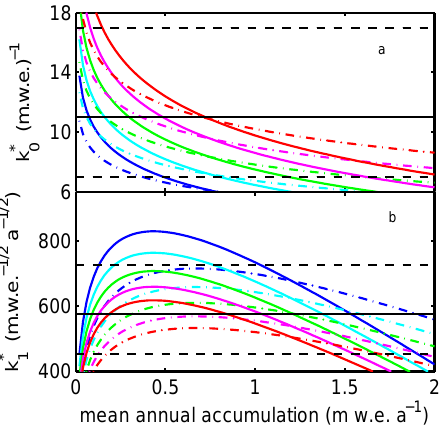
Figure 1. Vertical densification rates for ( a ) Stage 1 and ( b ) Stage 2 densification. Black lines show the Herron and Langway values (solid lines) with their uncertainties (dashed lines). Colored lines show the Ligtenberg values for mean annual temperatures of 230 (blue), 240 (cyan), 250 (green), 260 (magenta), and 270 K (red), with solid lines for Antarctic sites and dashed lines for Greenland sites. Simonsen et al. [15] modified the Arthern model by multiplying the r.h.s of Equation (13) by a simple scaling factor f 0 , and the r.h.s. of Equation (14) by another scaling factor f 1 and the terms ¯ a − 1/2 and exp( − 3.8 kJ mol − 1 /R T m ). This produces a Stage 2 expression that follows the